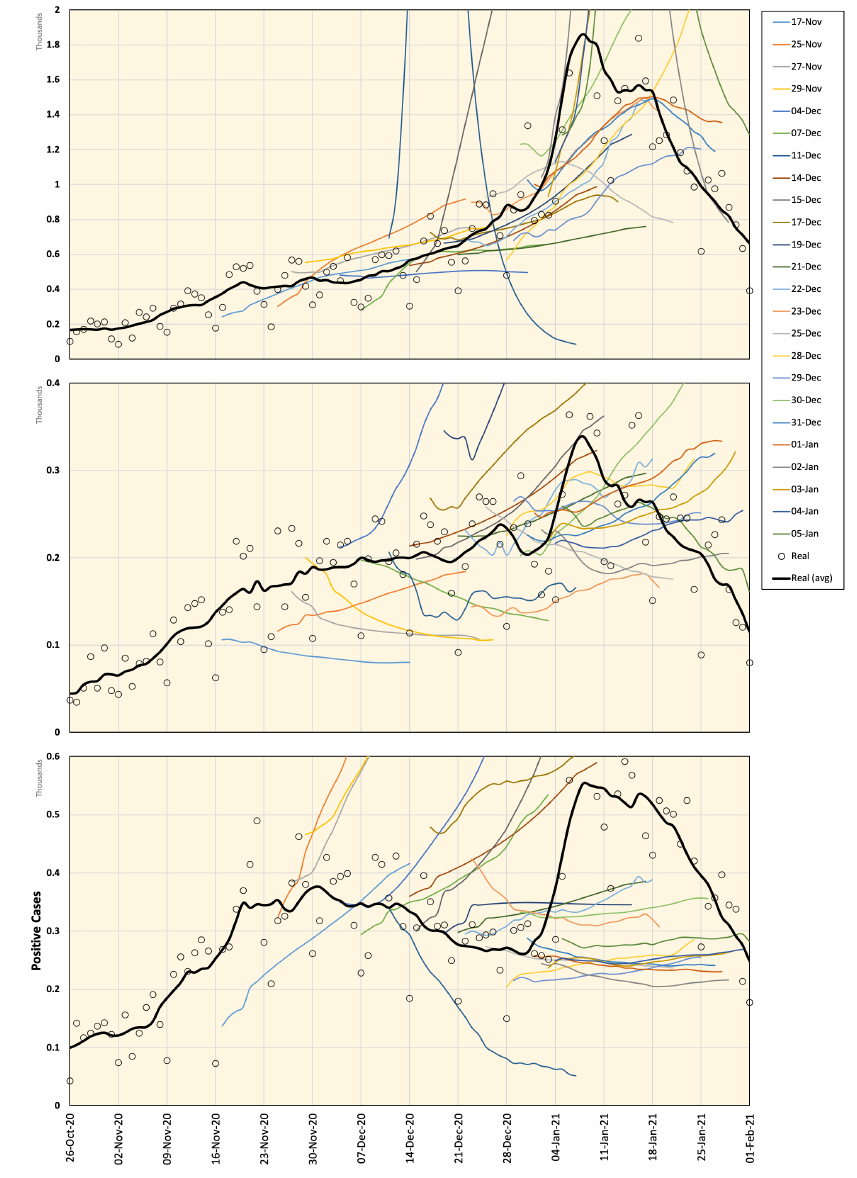
Figure 3. Google Cloud forecasting of DPC in Tokyo ( top ), Aichi ( middle ), and Osaka ( bottom ). Different versions are labeled with the forecasting start date and compared to the real values recorded from 26 October 2020 to 25 January 2021. All curves represent a 7-day average